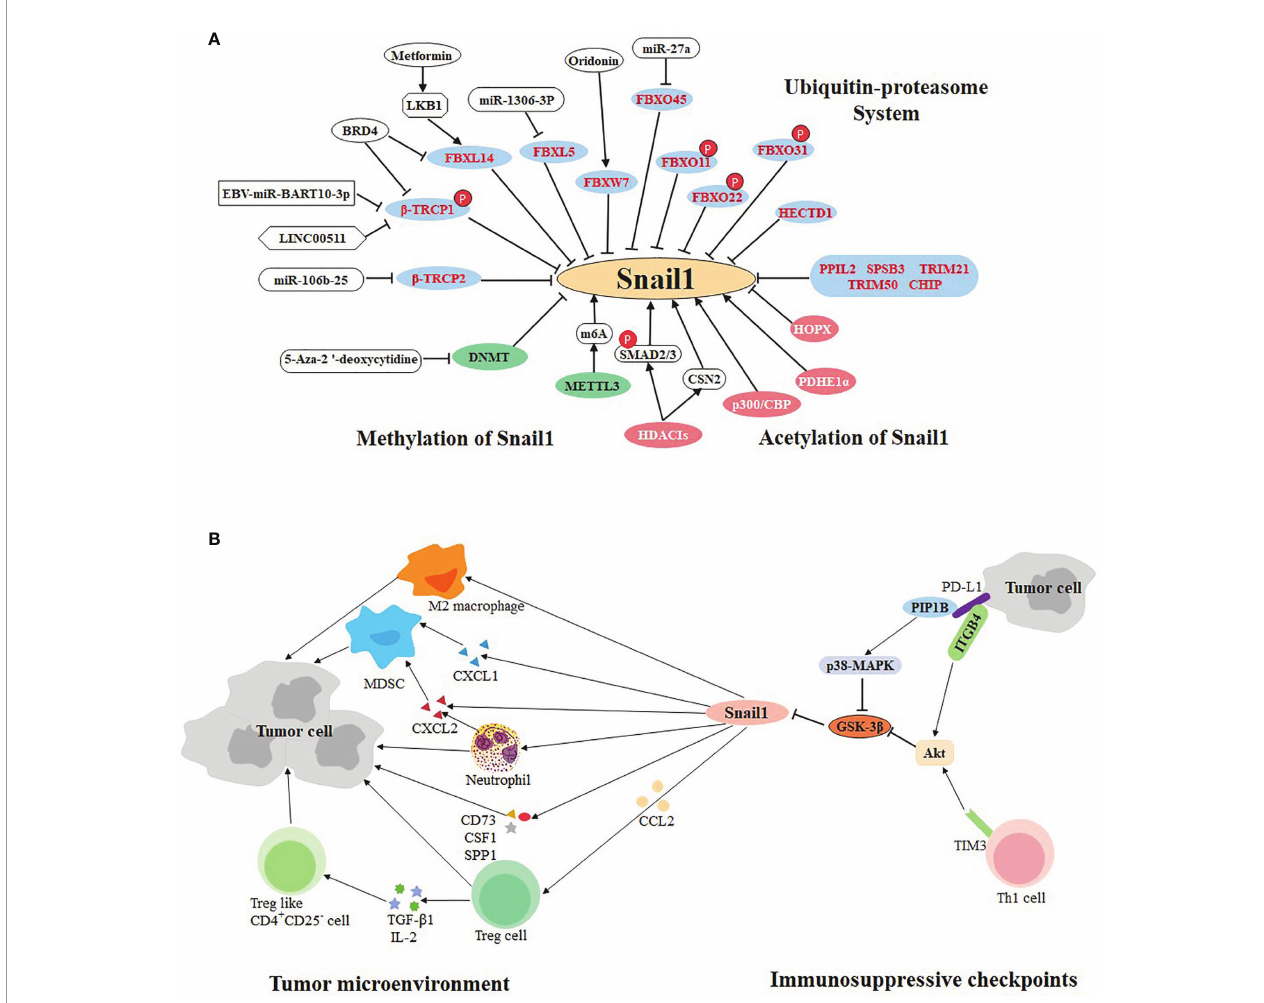
FIGURE 2 | Multifaceted regulation of SNAIL1. (A) Ubiquitination, methylation, and acetylation regulate the expression of SNAIL1. The ubiquitin E3 ligases in the blue circle negatively regulate the expression of Snail1. Small molecule compounds or drugs directly or indirectly act on E3 ligase to promote or inhibit the expression of Snail1. Molecules in the green and pink circles participate in methylation and acetylation of Snail1, respectively. (B) Bidirectional regulation of SNAIL1 and tumor immune environment. Snail1 recruits immunosuppressive cells (including Treg, MDSCs, M2 macrophages, neutrophils, and Treg-like CD4+CD25- cells) to participate in the formation of tumor microenvironment via cytokines, chemokines and their receptors. In addition, immunosuppressive checkpoints PD-L1 and TIM-3 can regulate the expression of Snail1 through different molecular